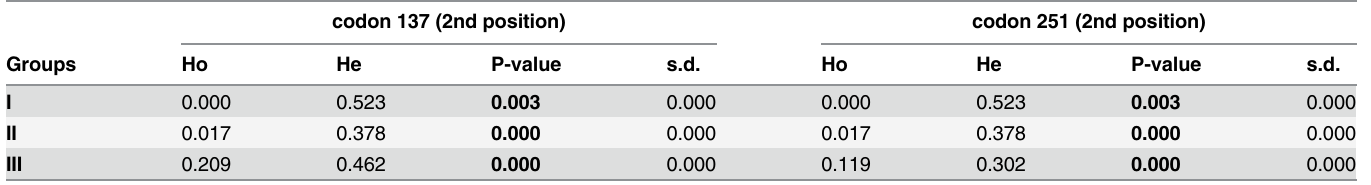
Table 6. Hardy-Weinberg equilibrium tests for the two polymorphic codon positions related to the determination of susceptibility and resistance. codon 137 (2nd position) codon 251 (2nd position)